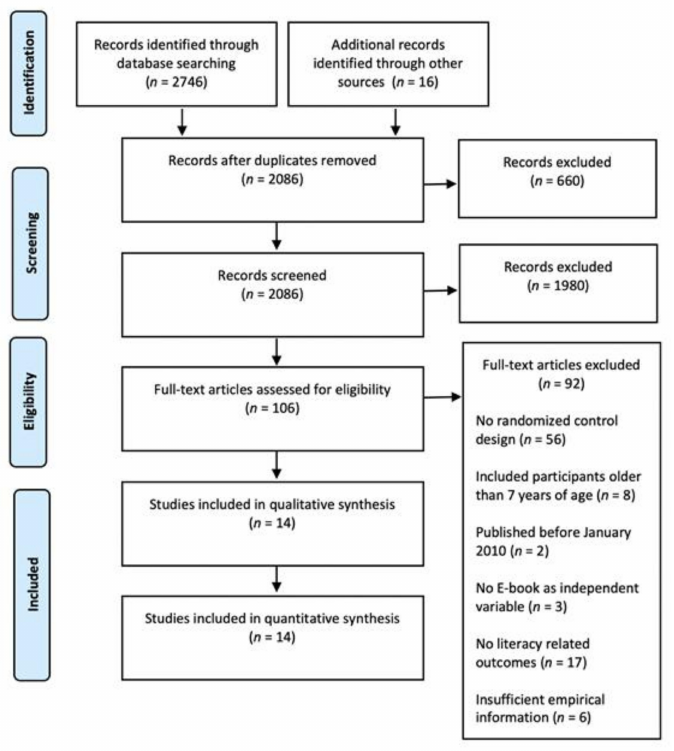
Figure 1. Prisma chart describing the search and inclusion procedures